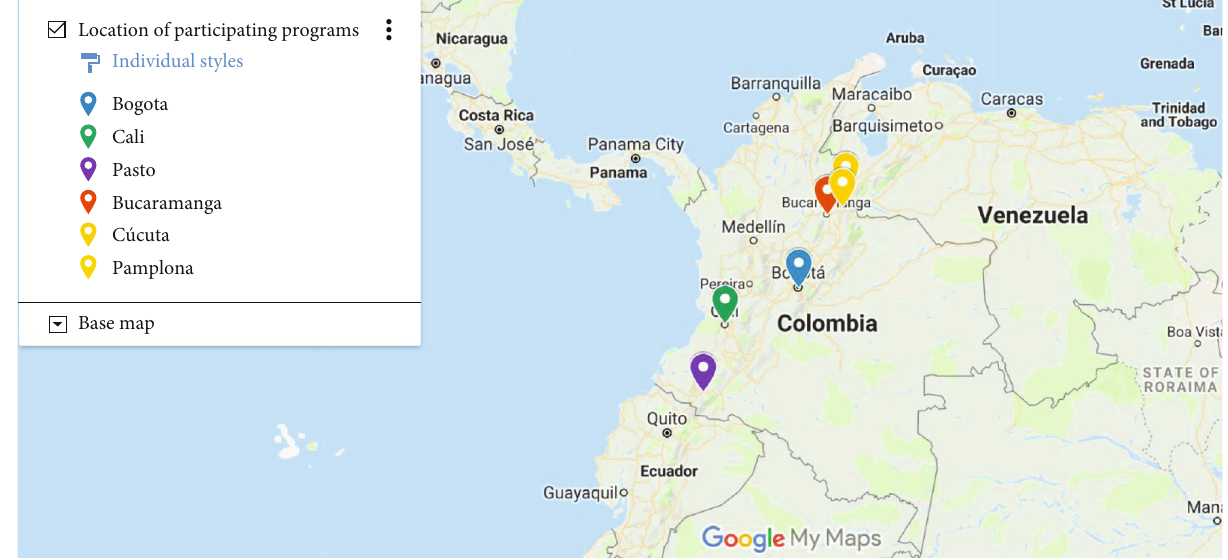
Figure 1: Geographical location of participating